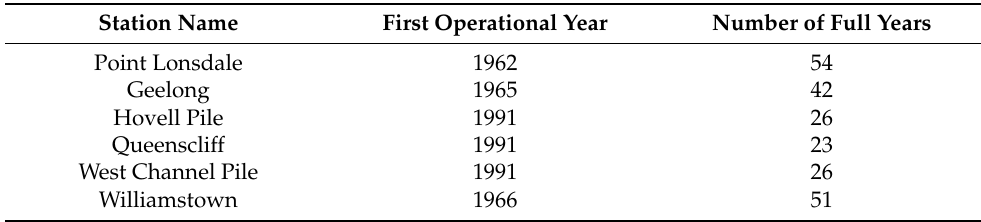
Table 1. Observational sea levels in Port Phillip Bay used in the present study.